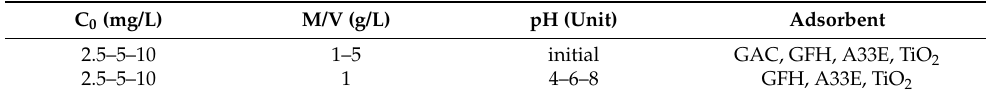
Table 4. Main operating conditions of isotherm